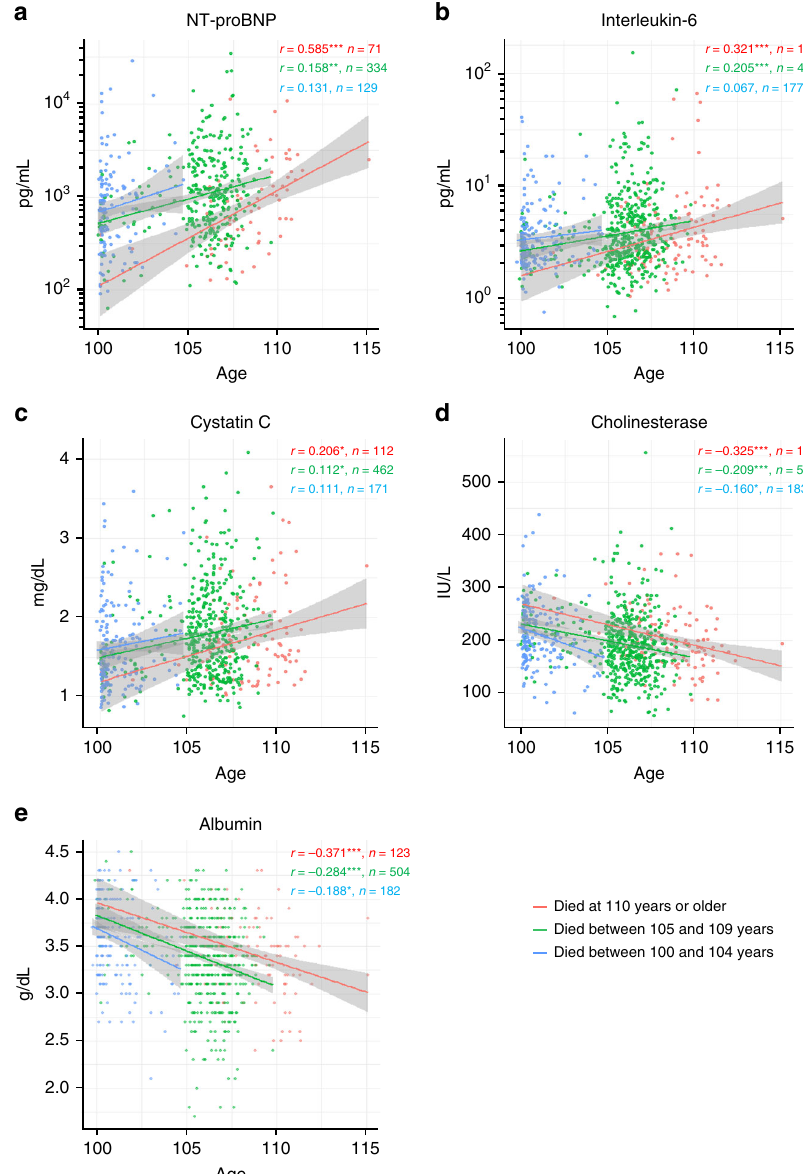
Fig. 8 Prognostic biomarkers in centenarians strati fi ed by the age at death. Spearman ’ s correlation coef fi cients of the relationships between prognostic biomarkers identi fi ed in Fig. 4 and albumin, and age at enrollment were calculated within decedent centenarian categories: decedent centenarians (died between 100 – 104 years, blue line), decedent semi-supercentenarians (died between 105 – 109 years, green line), and decedent supercentenarians (died at ≥ 110 years, red line). The shaded area represents the 95% con fi dence interval of the correlation line. All the biomarkers were assessed at the time of enrollment. Population sizes for the fi ve biomarkers differ due to variation in the bio-banking of samples. NT-proBNP indicates N-terminal